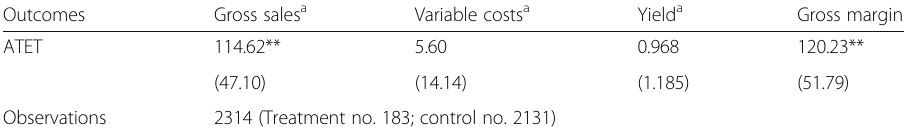
Observations 2314 (Treatment no. 183; control no.